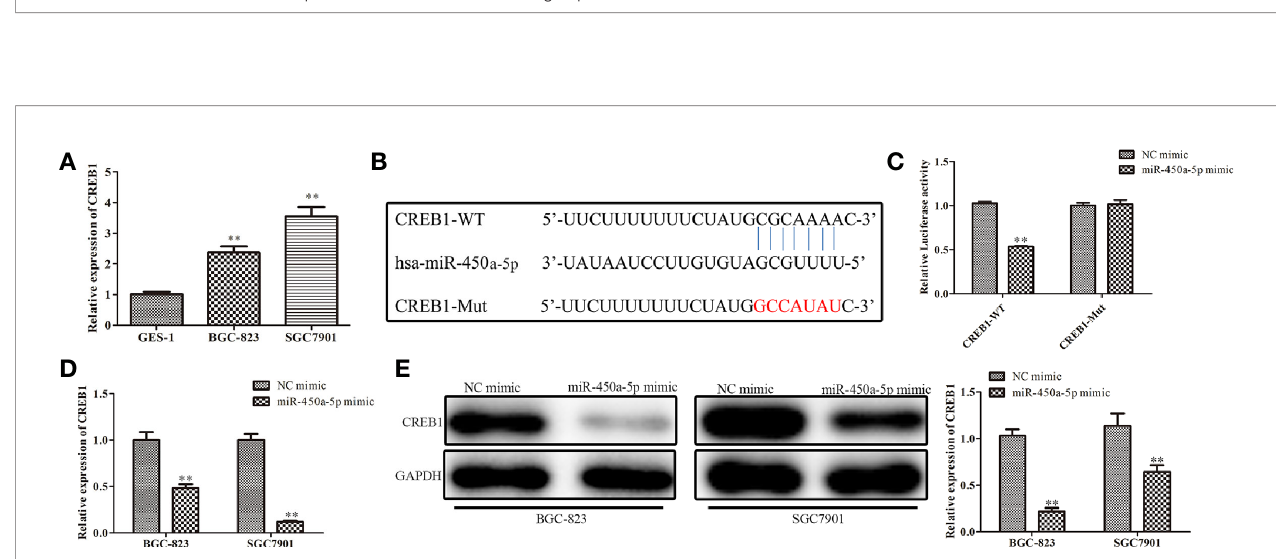
FIGURE 4 | MiR-450a-5p targets and negatively regulates CREB1. (A) The expression of CREB1 determined by RT-qPCR in GES-1, BGC-823, and SGC7801 cells. * P <0.05 vs. GES-1 group. (B) The binding sites between miR-450a-5p and CREB1 were predicted. (C) Dual luciferase reporter assay performed in HEK-293T cells to detect the interaction between miR-450a-5p and CREB1. ** P <0.01 vs. miR-NC group. (D) RT-qPCR on the CREB1 expression after transfection of miR-450a-5p mimic. ** P <0.01 vs. miR-NC group. (E) Western blot assay on the CREB1 expression after transfection of miR-450a-5p mimic. ** P <0.01 vs. miR-NC